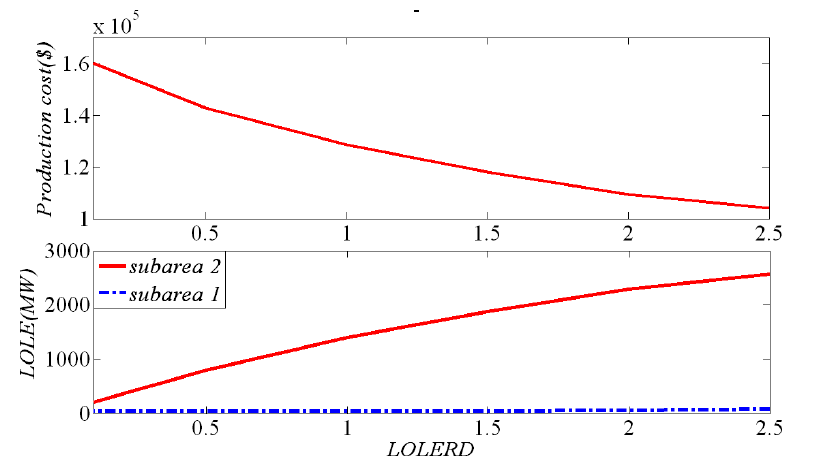
Figure 7. Effect of LOLERD on the production cost and